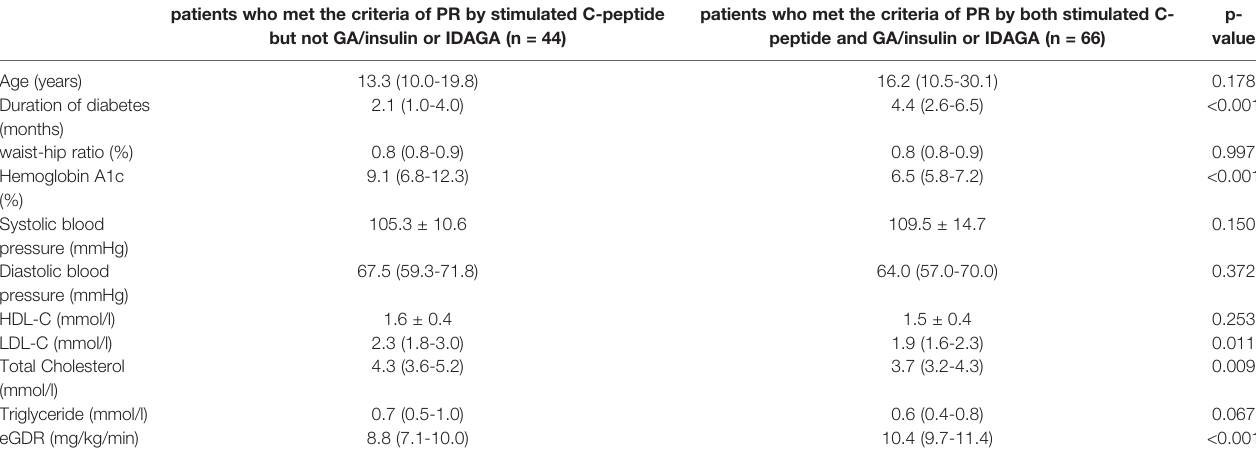
TABLE 2 | The differences in clinical characteristics between patients who met the criteria of PR only by stimulated C-peptide and those by both stimulated C-peptide and GA/insulin requirement or IDAGA. patients who met the criteria of PR by stimulated C-peptide patients who met the criteria of PR by both stimulated C- but not GA/insulin or IDAGA (n = 44) peptide and GA/insulin or IDAGA (n = 66)